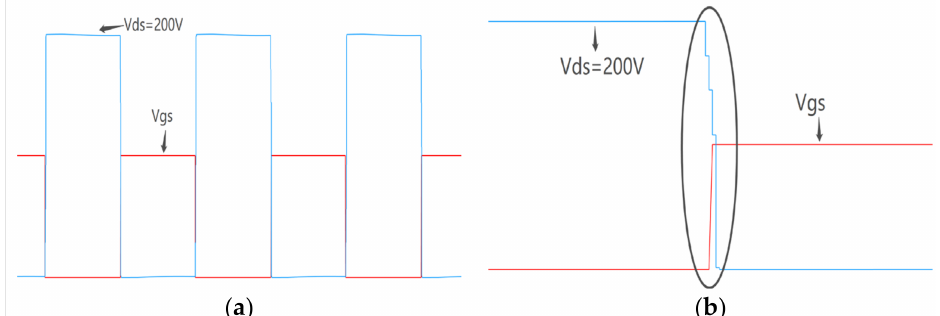
Figure 8. Simulation results for f s = 140 kHz: ( a ) Steady-state waveforms (time scale: 4 µ s/div); ( b ) partial amplification waveforms (time scale: 800 ns/div).